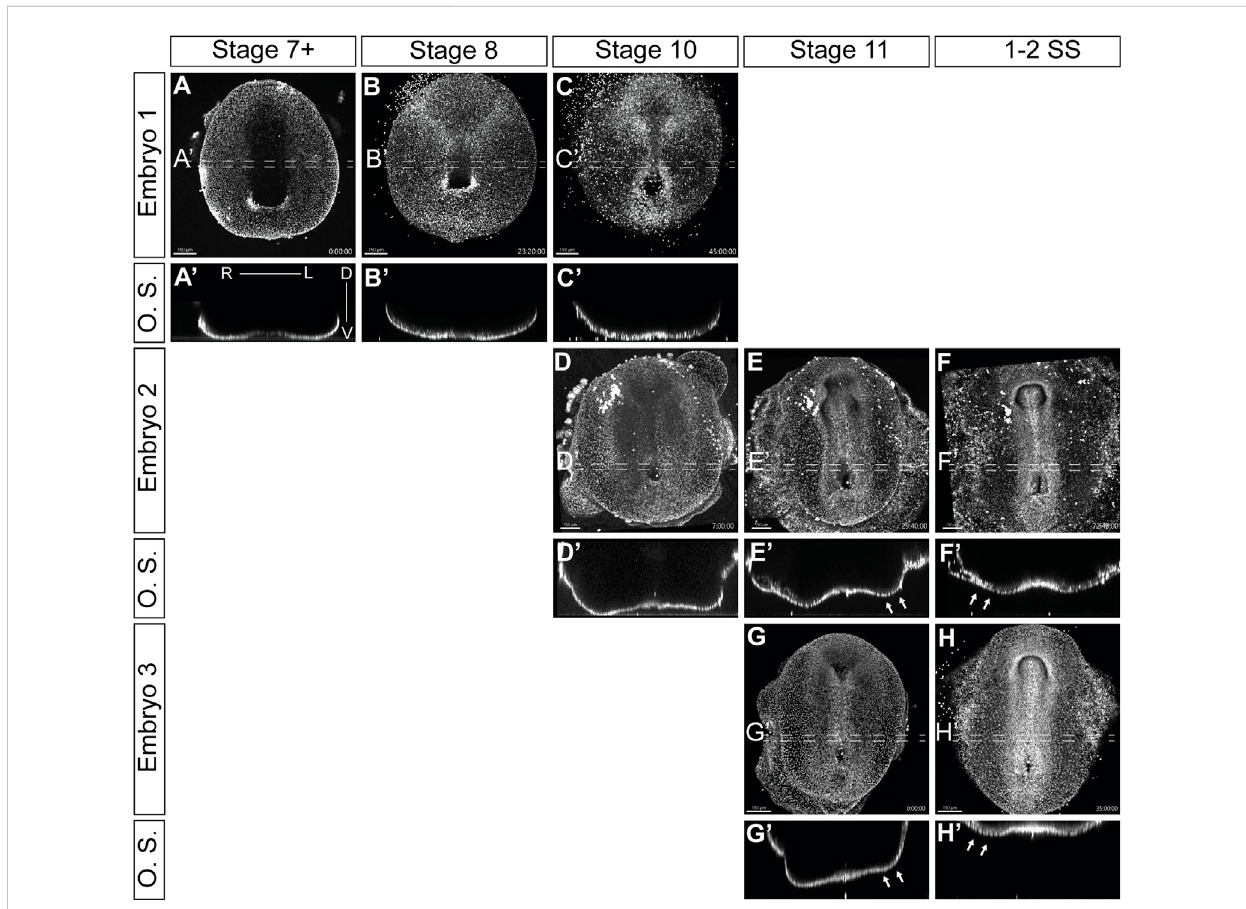
FIGURE 5 Videovisualizationofcellularmigrationsduringgastrulationandleft-rightpatterning. (A – H) StillimagesofdevelopingembryosfromSupplementary videos S2-S4 show ventral view of embryos cultured with 5-SiR-HoechstSTED DNAdye to label nuclei. The punctate lines show the approximate region of the 40 μ m optical section. (A 9 – H 9 ) Transverse optical sections (O.S) of embryos in (A – H) , from the regions, indicated by punctate lines. Section orientation is as indicated in (A 9 ) . Supplementary videos S2-S4 spanned different developmental stages, approximately assigned in the fi gure. White arrows in (E 9 , F 9 , G 9 , H 9 ) show the areas of signi fi cant morphological changes in a developing embryo. Scale bars are in the bottom left corner of images and are 150 μ